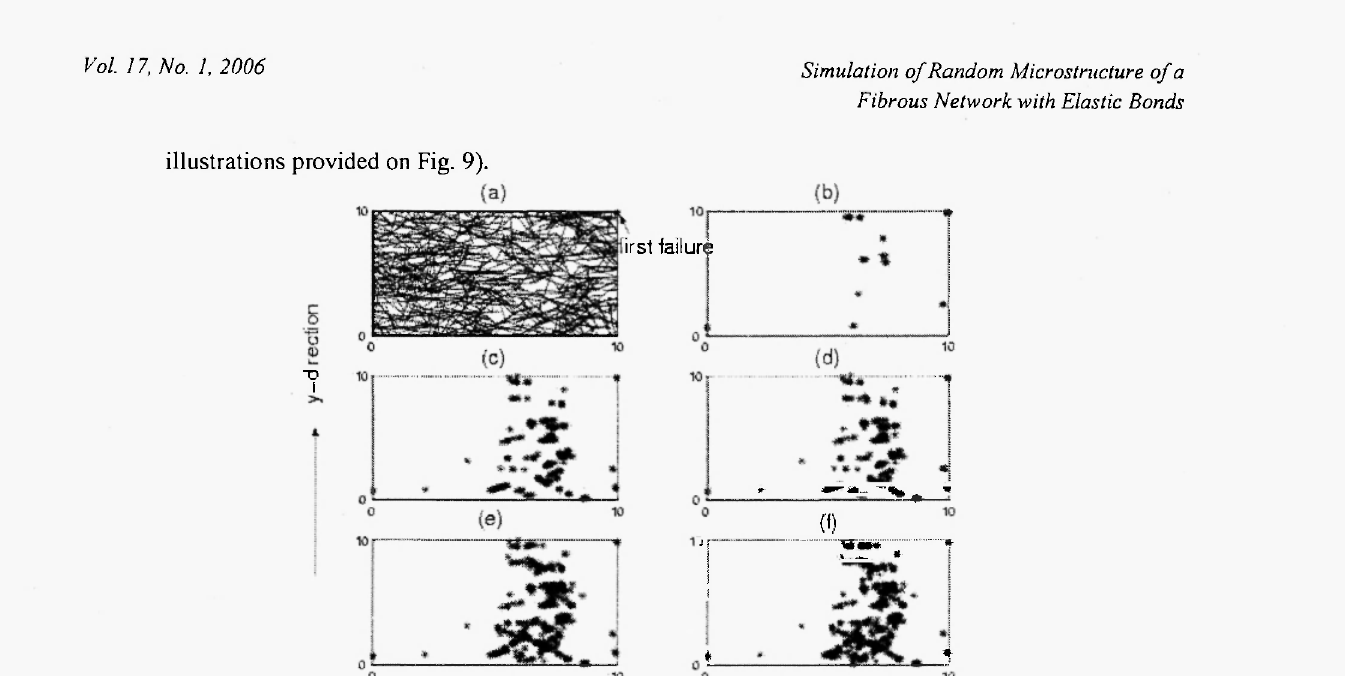
Fig. 9: Failure evolution: '*' marks the broken bonds between two following steps (a)-(b), (b)-(c), (c)-(d), (d)-(e), (e)-(f) - 'x' is the load